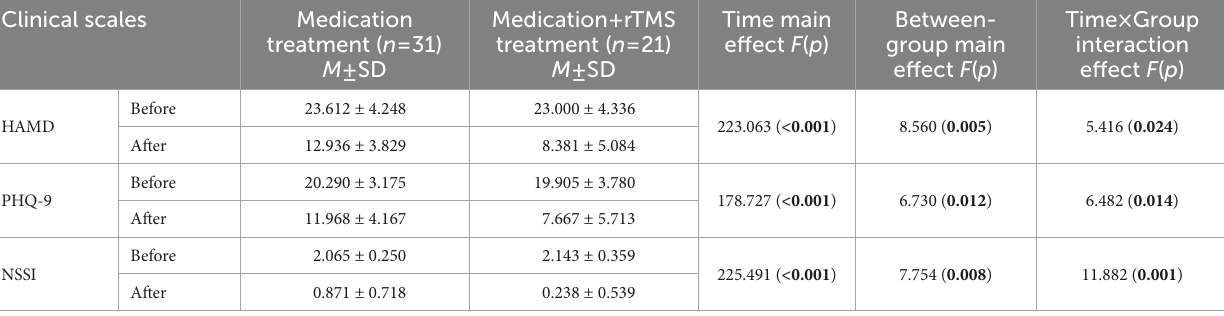
The bolded p values indicate statistical significance. We bolded for greater